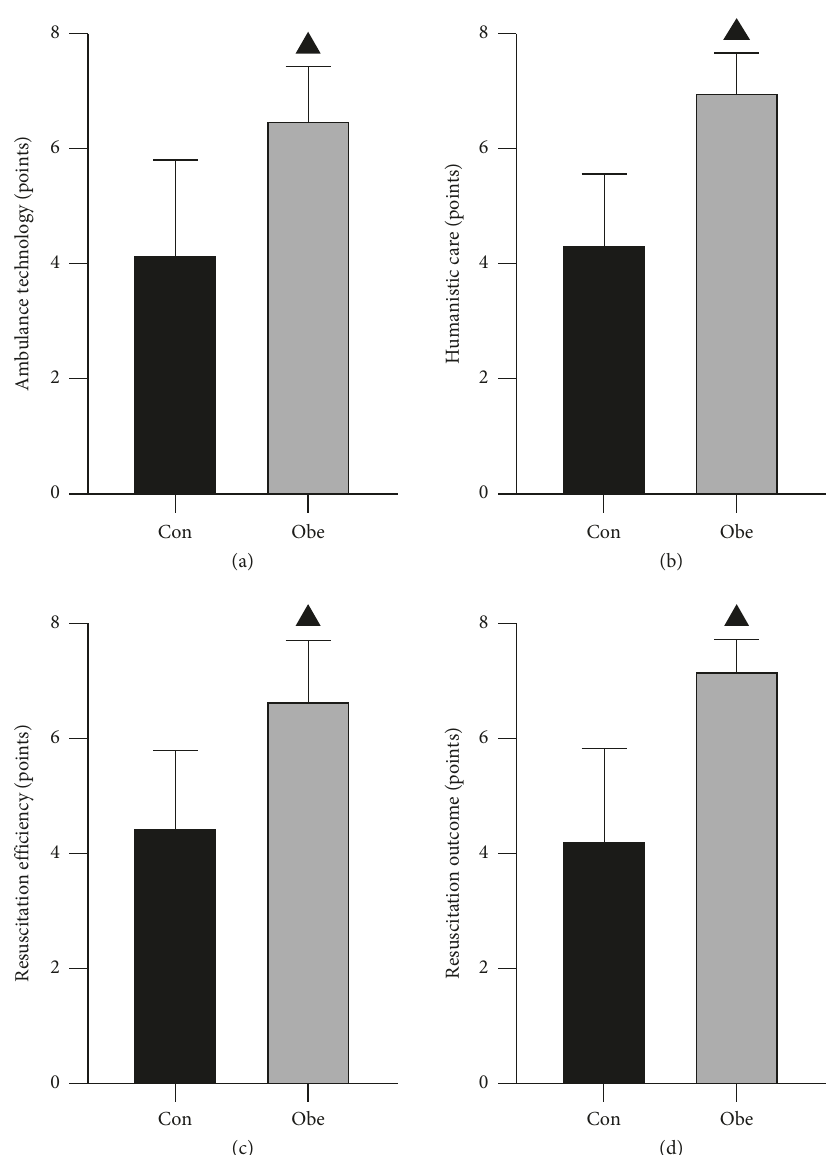
Figure 3: Comparison of nursing quality between the two groups. Note. ▲ indicates P < 0 . 05 compared with the control group. Table 2: Comparison of family satisfaction between the two groups (n, %). Group Very satisfied Basically satisfied Unsatisfied Satisfied Control group ( n �